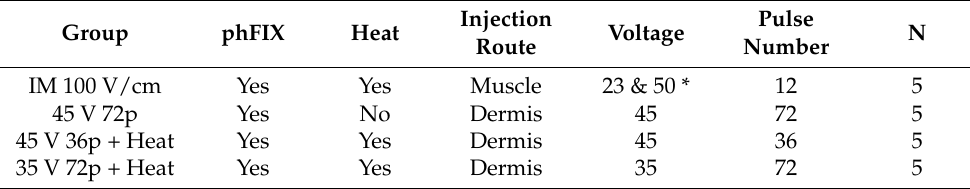
Table 3. Factor IX expression following GET with or without heat.